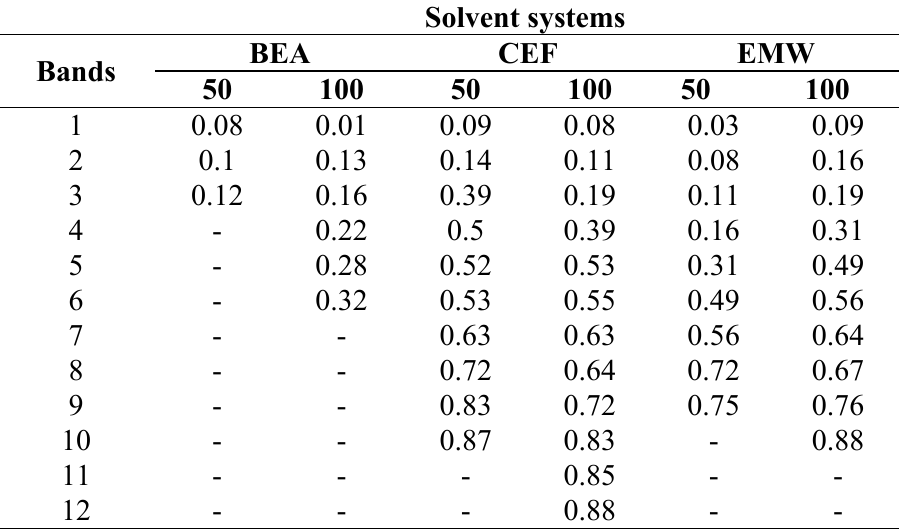
Table 3. R values for the different systems at different f